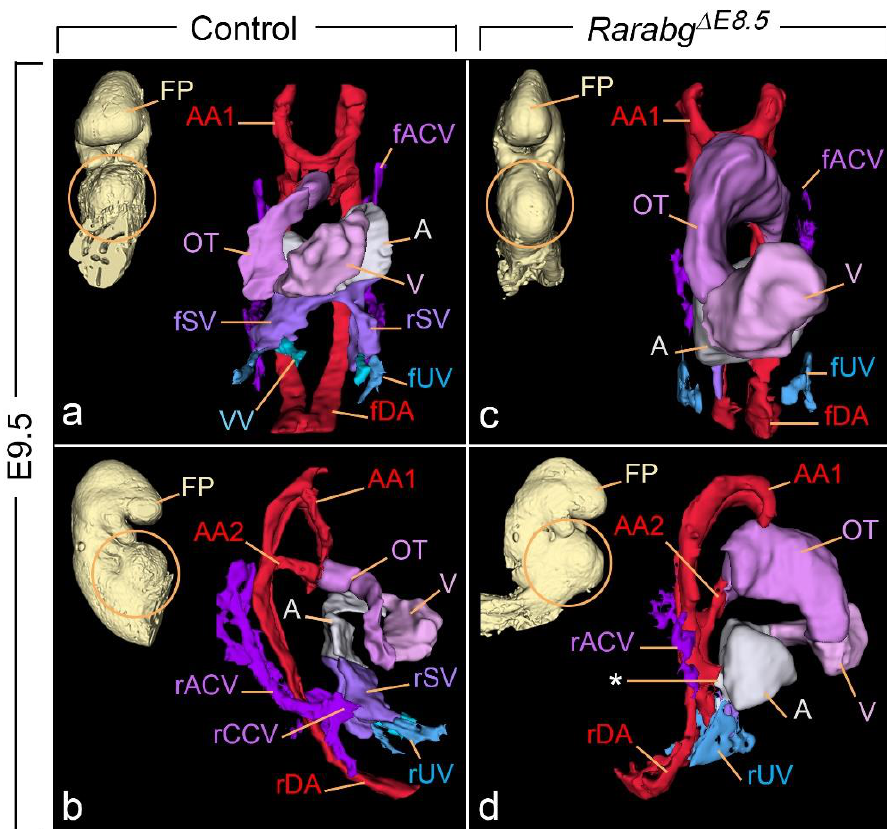
Figure 10. Frontal views ( a , c ) and right lateral views ( b , d ) of 3D-reconstructions of the heart region (encircled on the insets) of a control embryo ( a , b ) and of a Rarabg ΔE8.5 mutant littermate ( c , d ) at E9.5. A, primitive atrium; AA1 and AA2, 1st and 2nd aortic arches, respectively; fACV and rACV, left and right anterior cardinal veins, respectively; rCCV, right common cardinal vein; fDA and rDA, left and right dorsal aortas, respectively; FP, frontonasal process; fSV and rSV, left and right horns of the sinus venosus; fUV and rUV, left and right umbilical veins, respectively; V, primitive ventricle. The asterisk indicates an aorto-atrial fistula. Same magnification in ( a – d ).